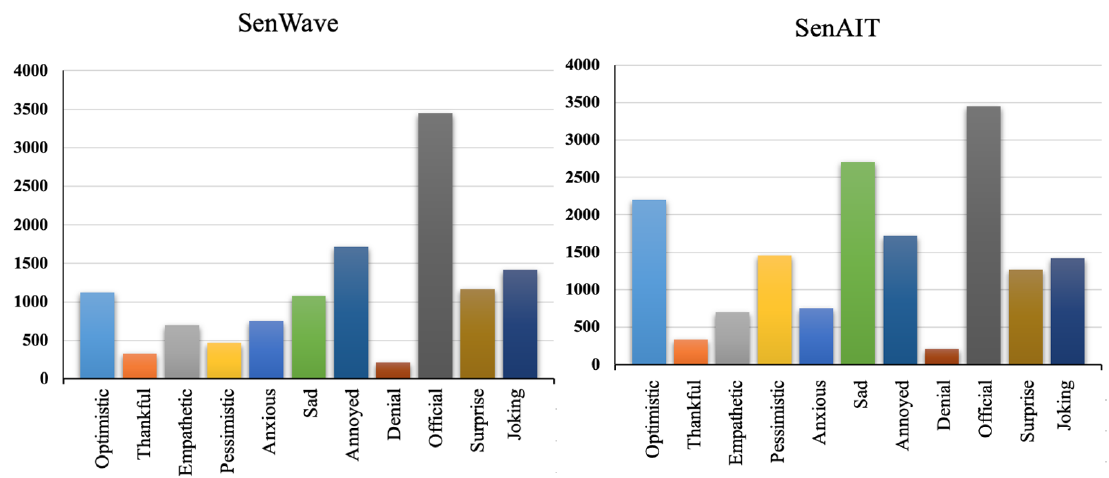
Figure 5. Emotions distribution of SenWave and SenAIT